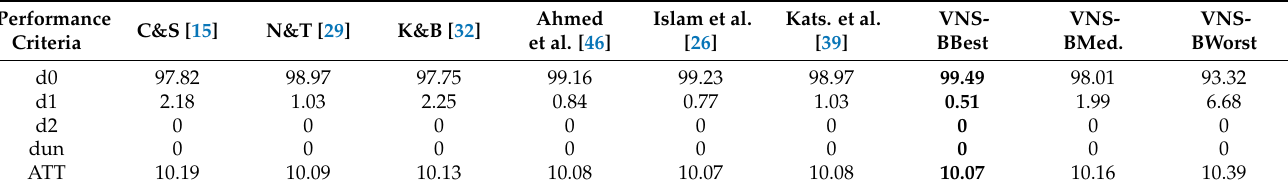
Table 7. Comparison of the final solution generated between methods for 8-Route